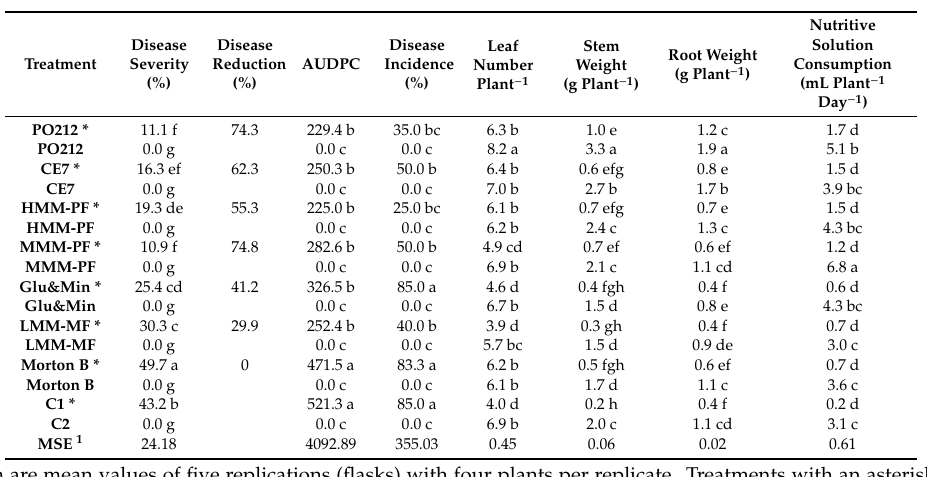
Table 6. E ff ect of CE7 fractions on the disease control caused by strain 1A of Fusarium oxysporum f.sp. lycopersici (FOL1A) and tomato plant